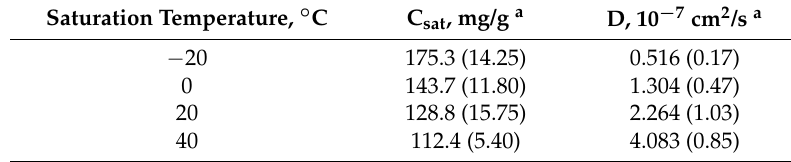
(a) indicates the uncertainties of the estimation with 95% confidence bounds were presented in parentheses.